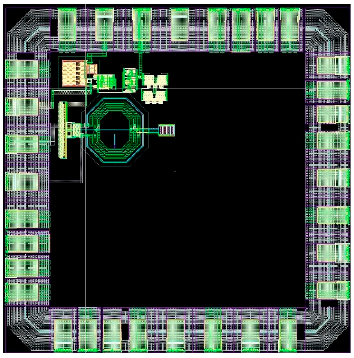
Figure 23. Draft floor plan of the test chip.